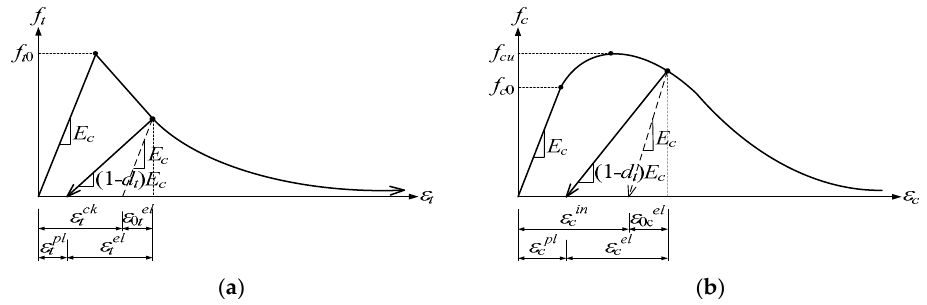
Figure 9. Concrete Damage Plasticity model: ( a ) tension behavior associated with tension stiffening; and ( b ) compressive behavior associated with compression hardening.